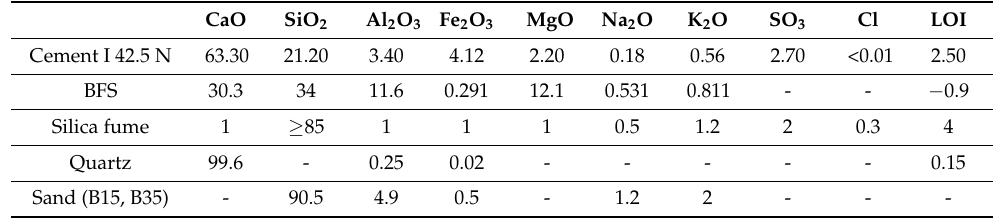
Table 1. Chemical composition of the material